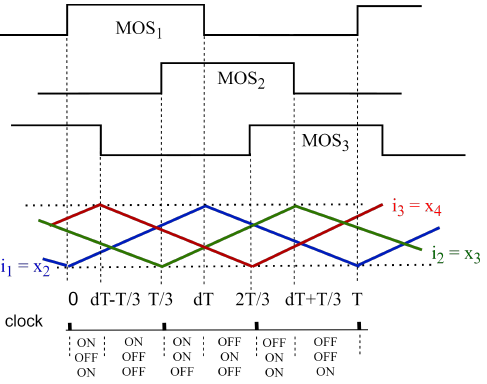
Figure 2. Gate pulses of MOS 1 , MOS 2 , and MOS 3 , and the inductor currents i L 1 , i L 2 , and i L 3 in steady